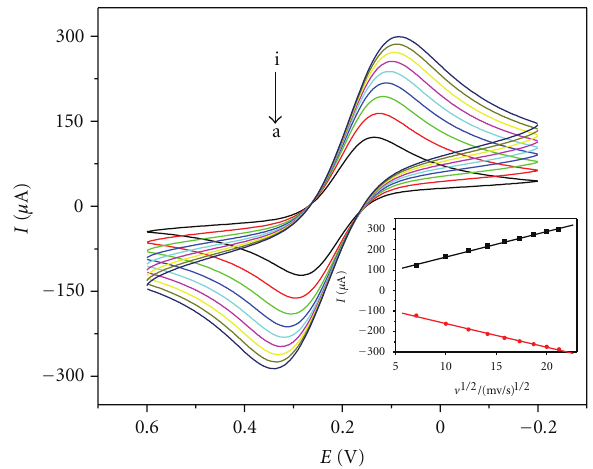
Figure 3: Cyclic voltammograms of the modified electrode at di ff erent scan rates (from a to i): 50, 100, 150, 200, 250, 300, 350, 400, and 450 mV · s − 1 in 5mM [Fe(CN) 6 ] 4 − / 3 − solution. All potentials are given versus SCE. The inset shows the dependence of redox peak currents on the square root of scan